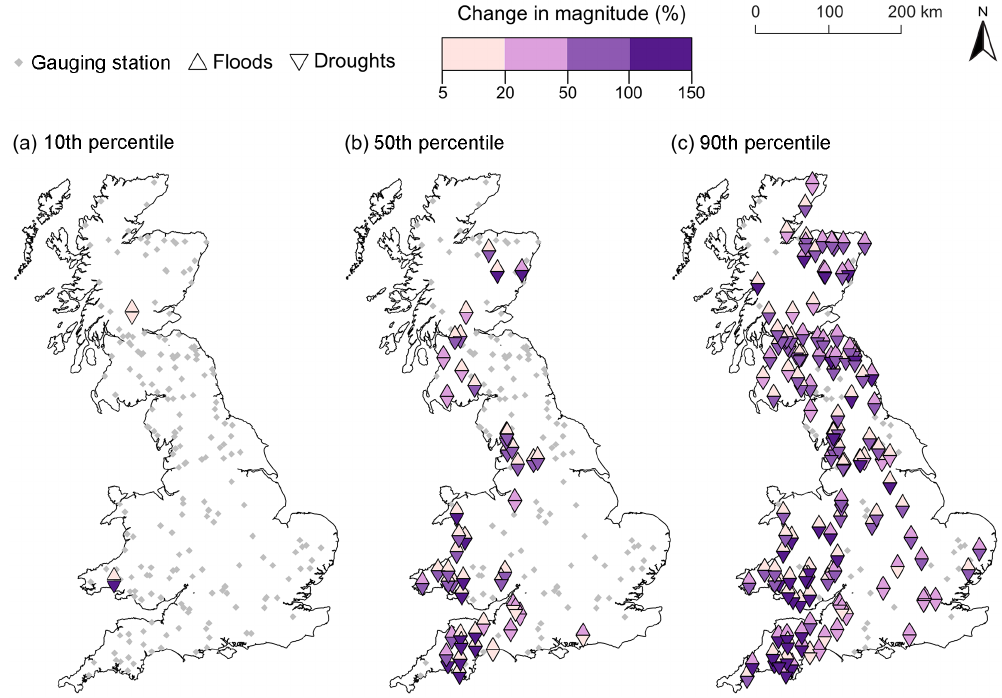
Figure 6. Changes in magnitude of the hydro-hazards for the hot-spots in Great Britain for the (a) 10th, (b) 50th, and (c) 90th percentiles.